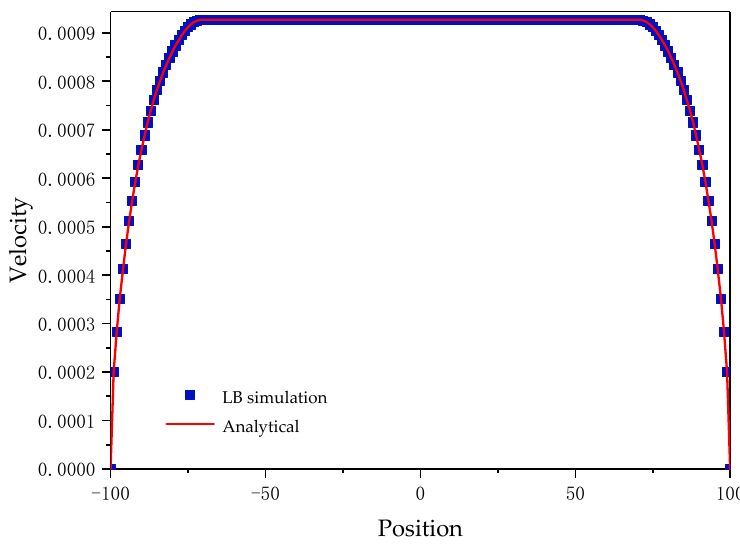
Figure 10. Comparison of LB simulation results and analytical solutions for Poiseuille flow in porous media.